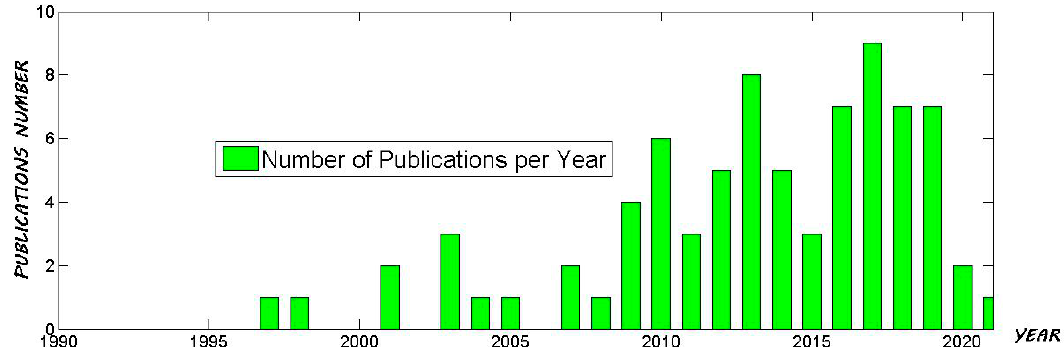
Figure 1. A graphical summary of the selected papers that take into account seasonality, cultivar or production year in investigation of food provenance per year.